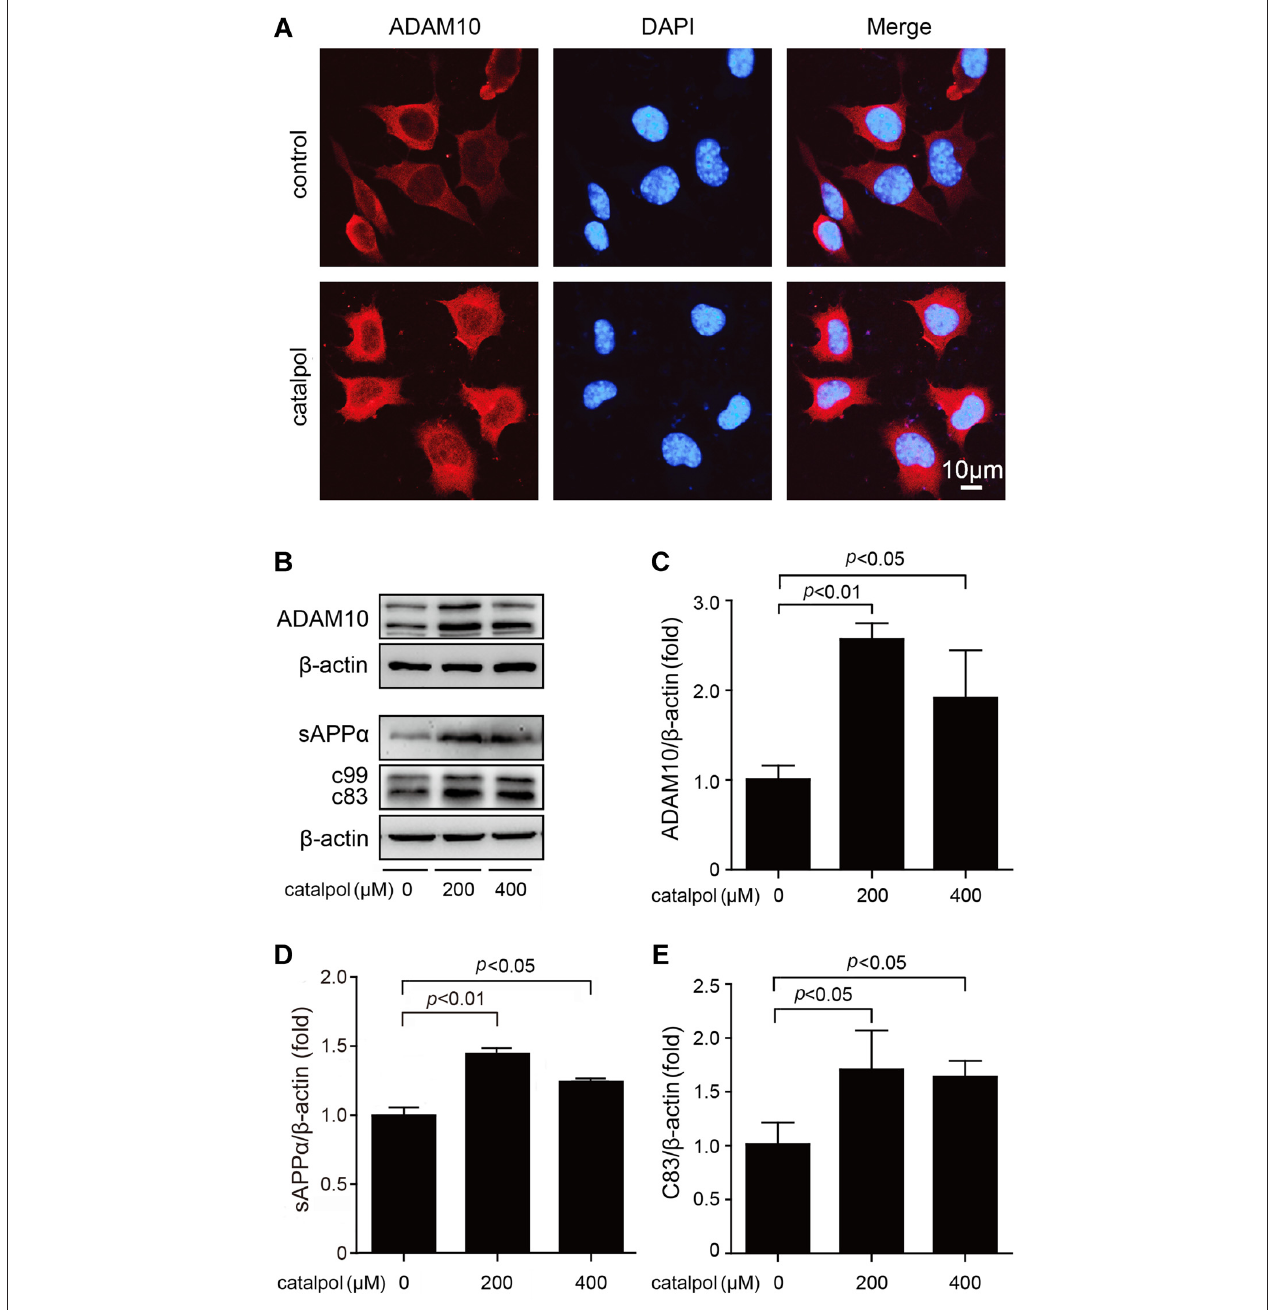
FIGURE 3 | Catalpol increased the expression levels of A disintegrin and metalloproteinase domain-containing protein 10 (ADAM10) and its proteolytic products sAPP α and C83. (A) Confocal microscopic images showing an increased immunofluorescence of ADAM10 in SweAPP N2a cells treated with catalpol at 200 µ M for 18 h. Nucleus were stained with DAPI. (B–E) Immunoblot analysis shows the expression level of ADAM10 ( B , representative pictures; C , quantification), the expression level of sAPP α ( B , representative pictures; D , quantification). The expression levels of C83 ( B , representative pictures; E , quantification) was detected after cells pretreated with the γ -secretase inhibitor L-685, 485. Western blot results showed that catalpol treatments significantly increased the protein levels of ADAM10, sAPP α and C83, after SweAPP N2a cells treated with catalpol (200 and 400 µ M) for 18 h. The data are expressed as the mean ± SEM. n = 3. The p values were calculated using one-way ANOVA.